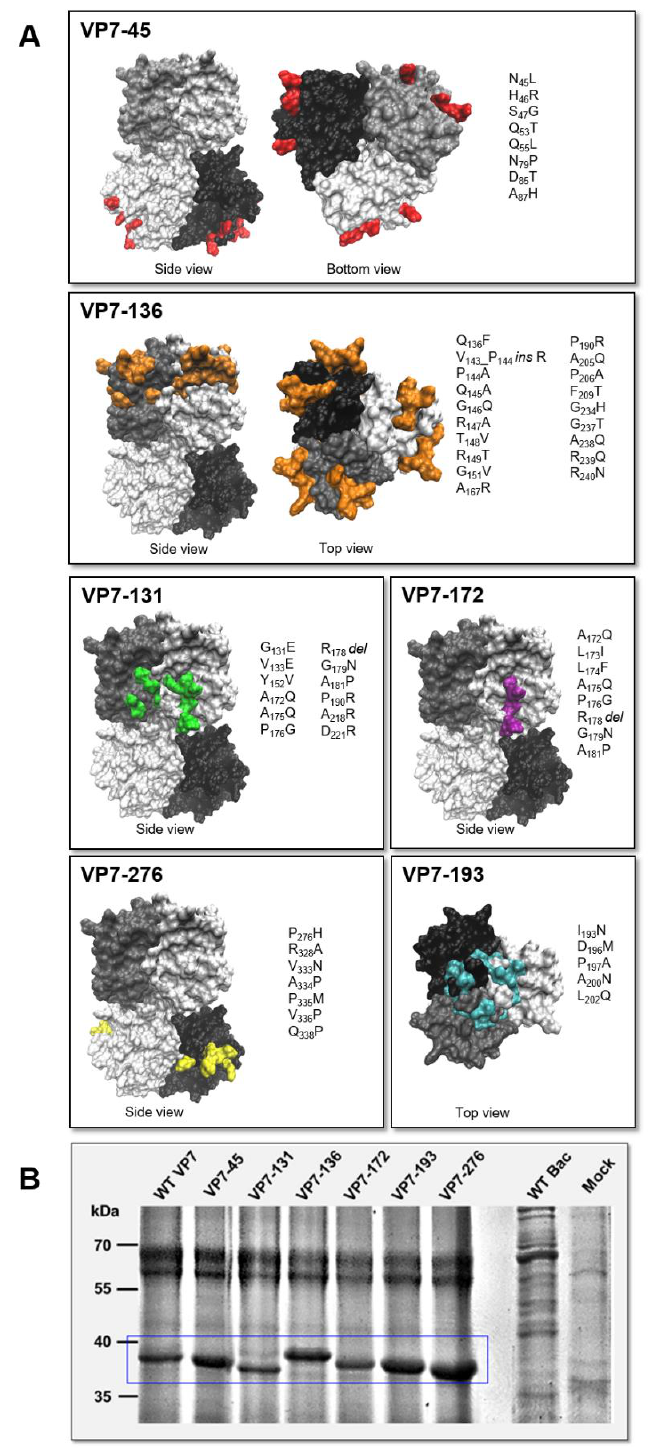
Figure 1. Generation and expression of modified AHSV VP7 proteins: ( A ) Summary of VP7 modifi- cations for construction of the VP7 mutant proteins. Three-dimensional models of the AHSV trimer are depicted with viewpoint indicated, i.e., side, top, or bottom view. Each monomer of the trimer is coloured grey, white, or black. The amino acid substitutions are highlighted in colour in each trimer, and the substitutions are illustrated on the right of each trimer model. ( B ) Confirmation of the expression of modified AHSV VP7 proteins using 12% SDS-PAGE. Insect cells were infected at an MOI of 10